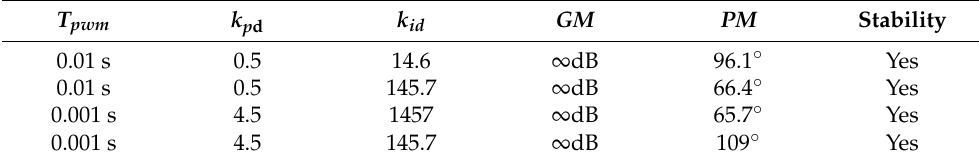
Table 3. The simulation and analysis results of the q-axis current of the torque closed-loop control. T pwm k p q k iq GM PM Stability 0.01 s 0.001 s